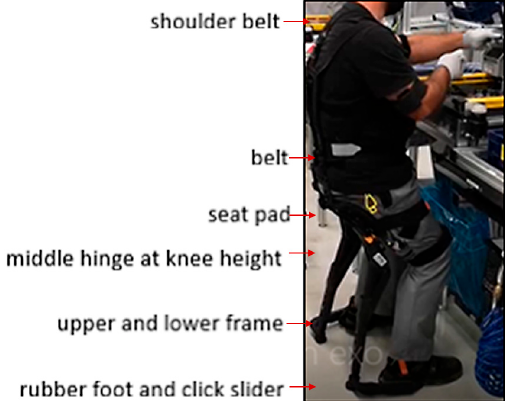
Figure 1. Lower body exoskeleton—Chairless Chair 2.0 (CC 2.0). Exoskeleton was used in Experiment 2 (EXO): minimizing the physical load by ergonomic sit-stand pattern.